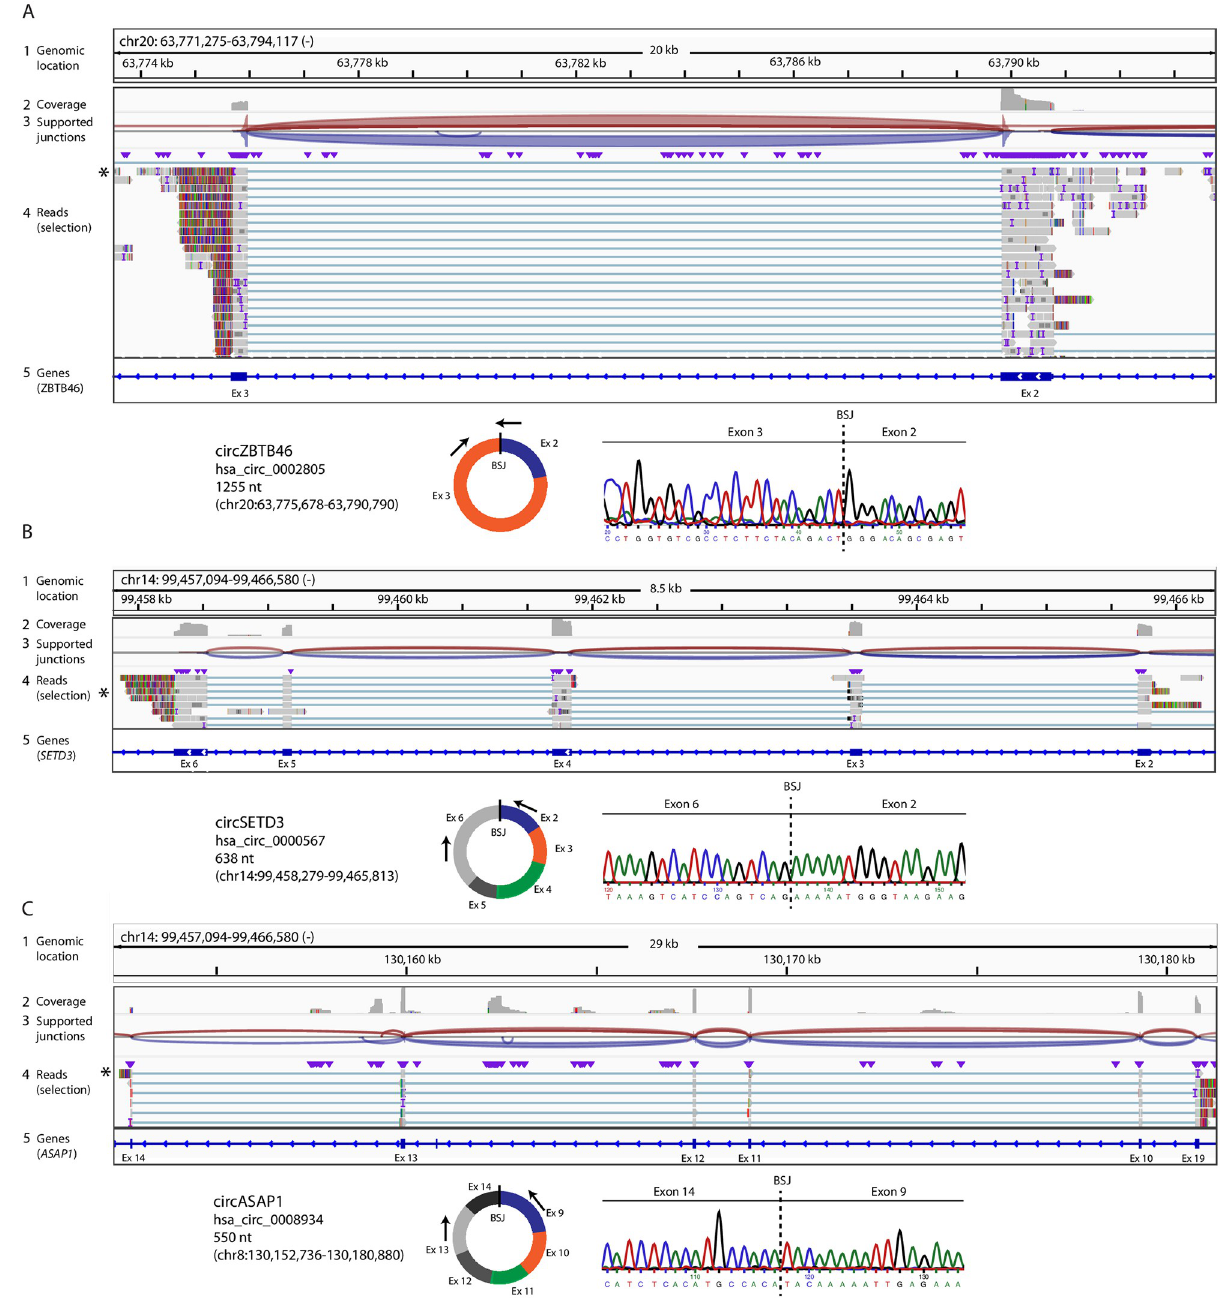
Fig 5. circRNAs detected by Nanopore were validated by Sanger sequencing. 3 different circRNAs (A: circZBTB46, B: circSETD3, C: circASAP1) detected by Nanopore-seq were amplified by RT-PCR using cDNA from COST ALCL cells and analyzed by Sanger sequencing. For each panel, the alignment of long reads against the exons that form the circRNA is shown in the upper part as visualized by IGV Genomics Viewer (tracks as in Fig 3). In the lower part a scheme of the circRNA is shown, together with the localization of the used primers and the BSJ-sequence obtained by Sanger sequencing. The circbase.org ID is mentioned [14]. BSJ, back-splice junction.